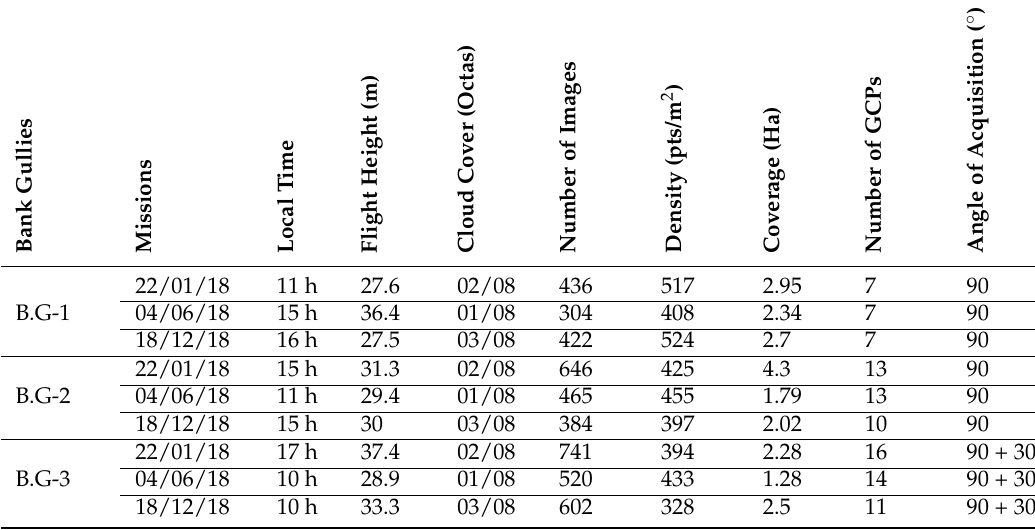
Table 1. Characteristics of UAV photo